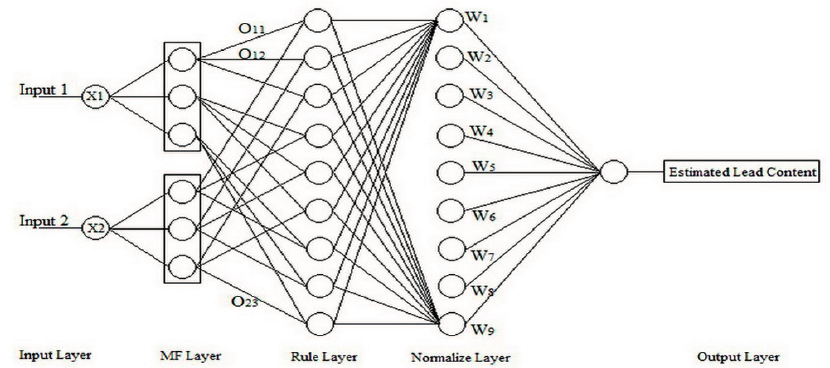
Figure 1. The structure of fuzzy neural network with two inputs and three membership functions. Neural networks and fuzzy systems are combined together to create fuzzy neural network